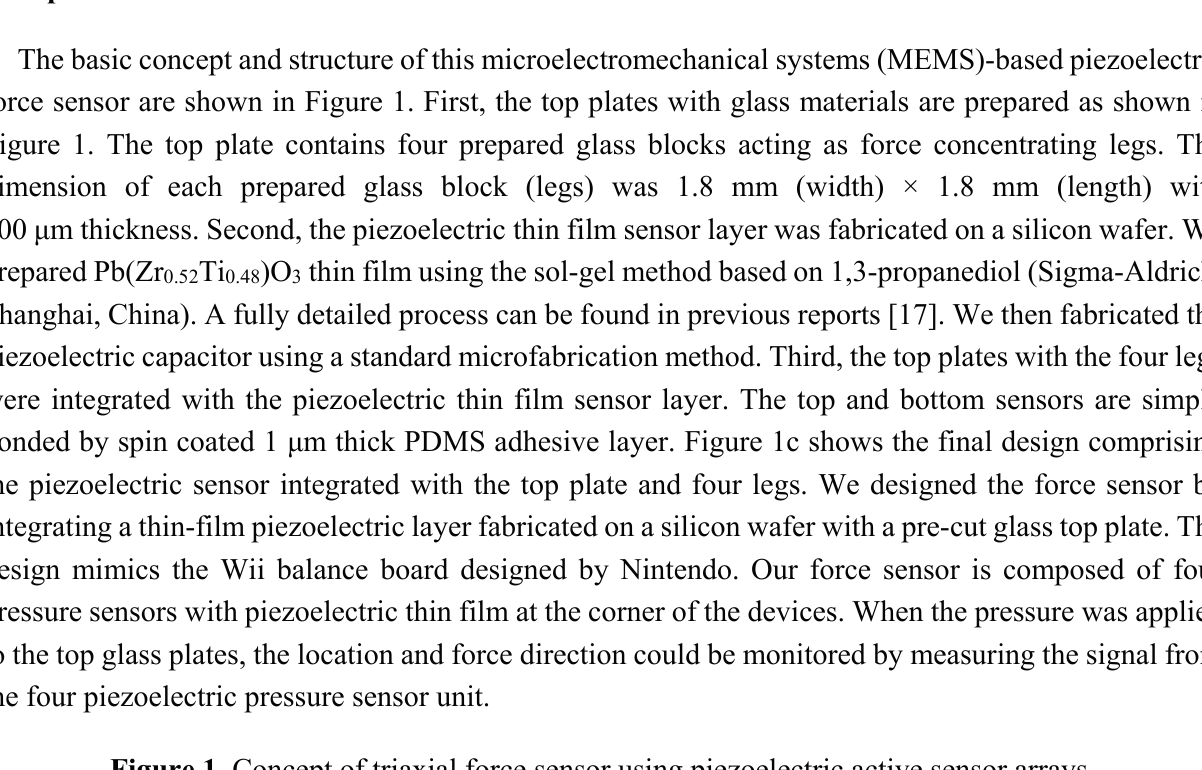
Figure 1. Concept of triaxial force sensor using piezoelectric active sensor